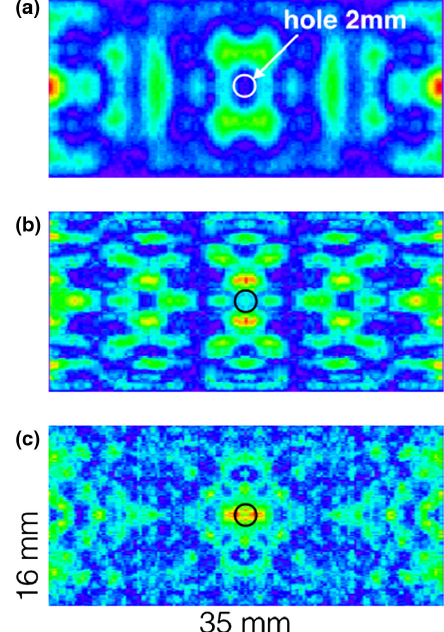
FIG. 20. Amplitude profile of the laser on output mirror, for